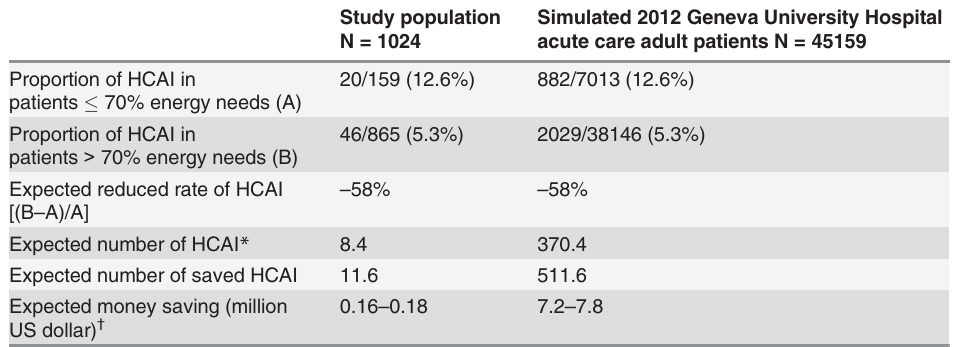
Table 4. Estimation of money saving based on the hypothesis that increasing energy intake from (cid:3) 70% to > 70% would have reduced the number of healthcare-associated infections (HCAI). Study population N =